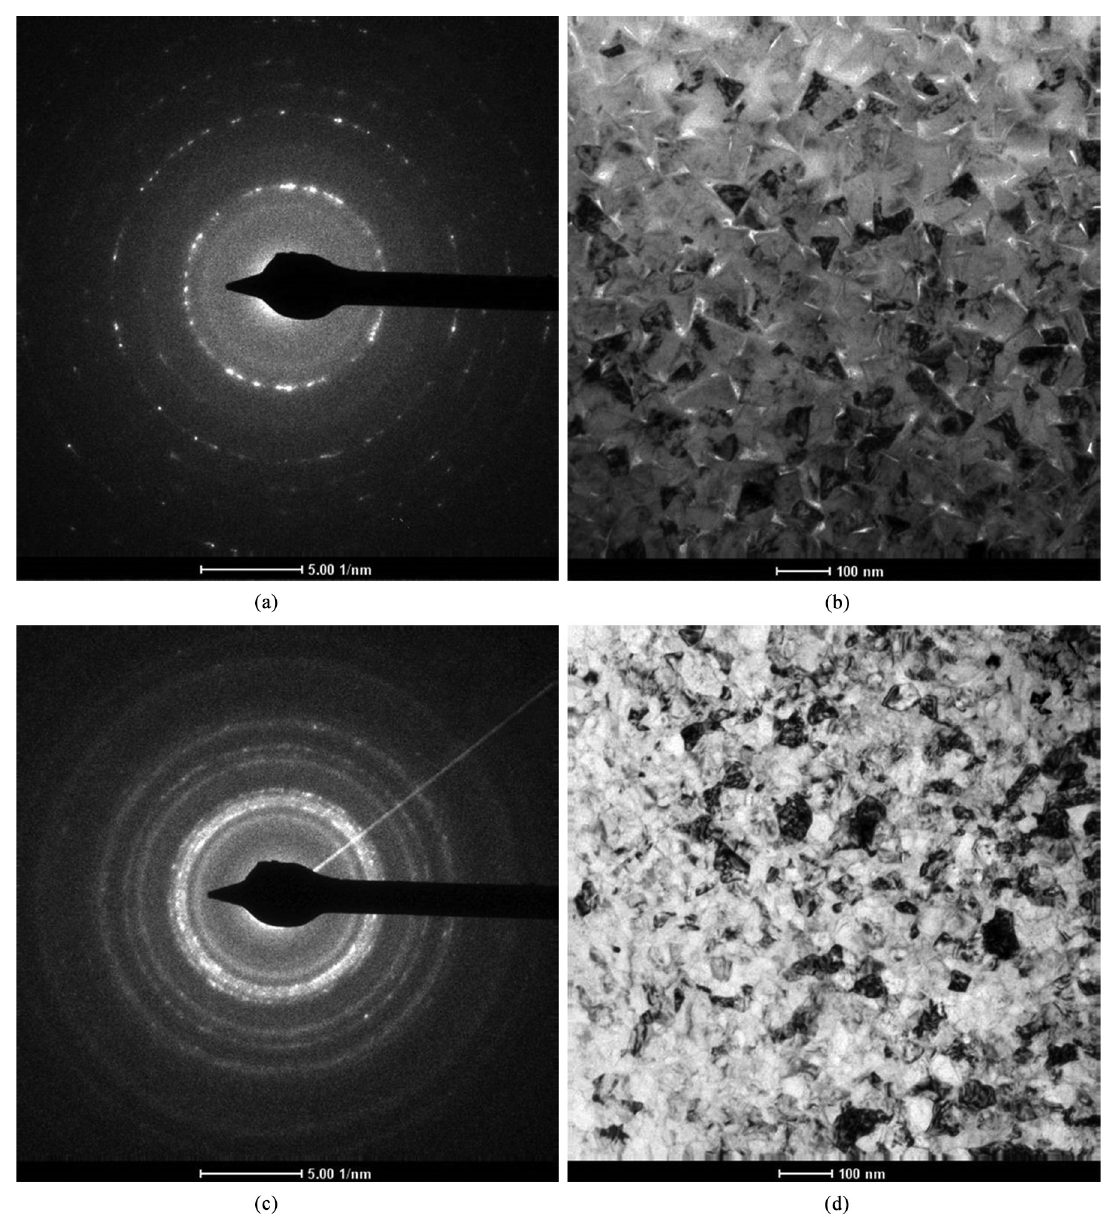
Figure 3. SEAD patterns of film 2# (a), 3# (c), and bright-field TEM images of film 2# (b) and 3#